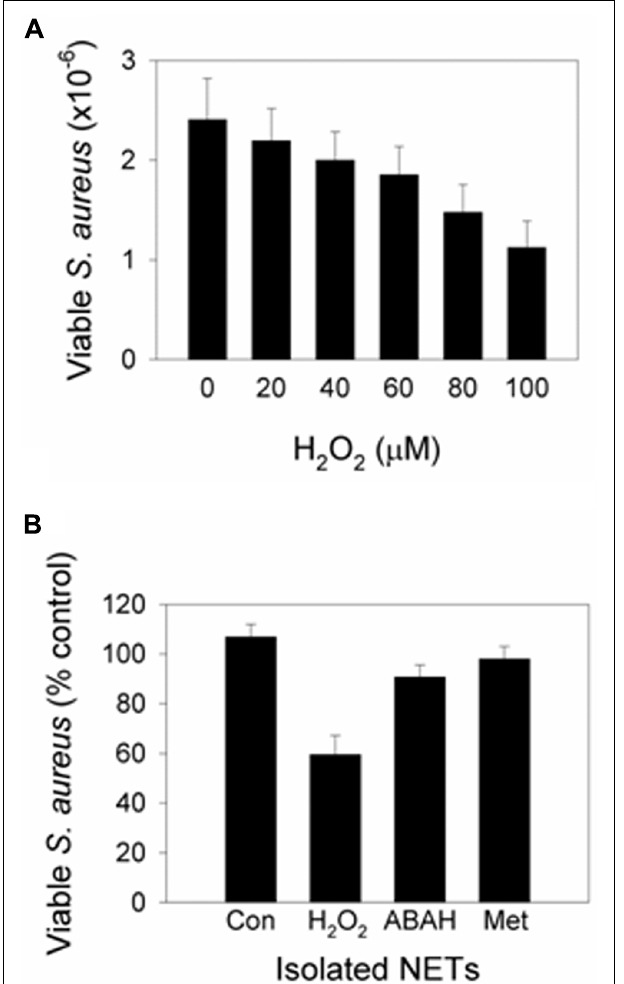
FIGURE 2 |Addition of H 2 O 2 to NETs induces MPO-dependent killing. Neutrophils were stimulated with PMA to form NETs then incubated with S. aureus in the presence or absence of (A) varying concentrations of H 2 O 2 or (B) 100 μ M H 2 O 2 (added in 20 μ M aliquots every 5 min to facilitate MPO turnover). At the examined concentrations, H 2 O 2 in the absence of NETs had no significant effect on S. aureus viability. (A) Bacterial numbers significantly decreased with ≥ 40 μ M H 2 O 2 ( p < 0.05, t -test on normalized data, n = 3). (B) Bacterial viability decreased with H 2 O 2 ( p < 0.001), and inhibition of MPO with ABAH and scavenging of HOCl with methionine (Met) prevented killing ( p < 0.01; one-way ANOVA with Holm–Sidak pairwise comparison, n = 5). Results are presented as percent of control cells (Con) incubated with NETs alone. Data obtained with permission from Parker etal.